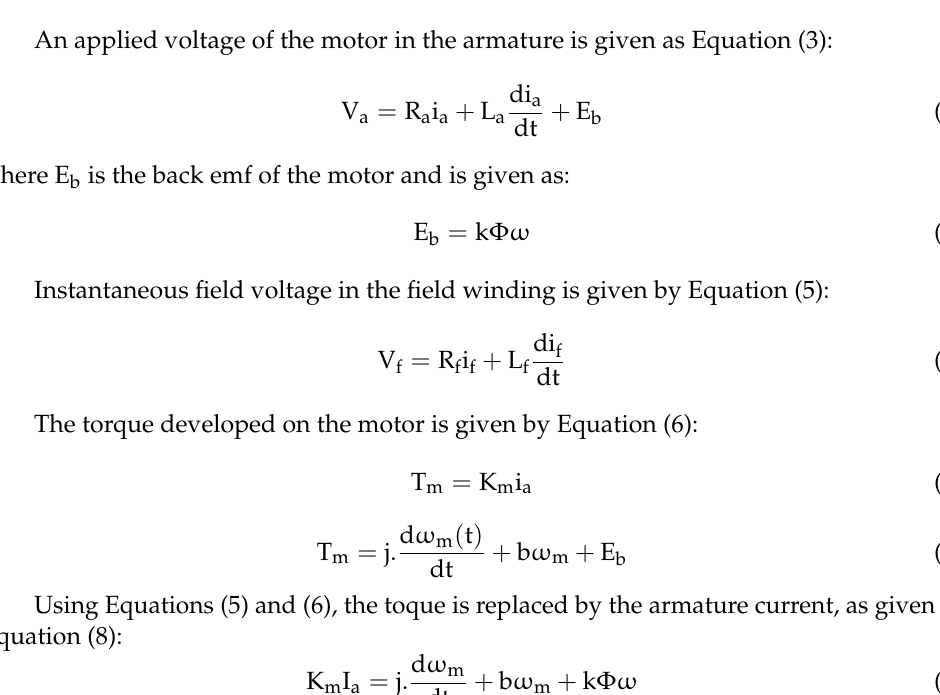
Figure 1. Circuit diagram of SEDC.